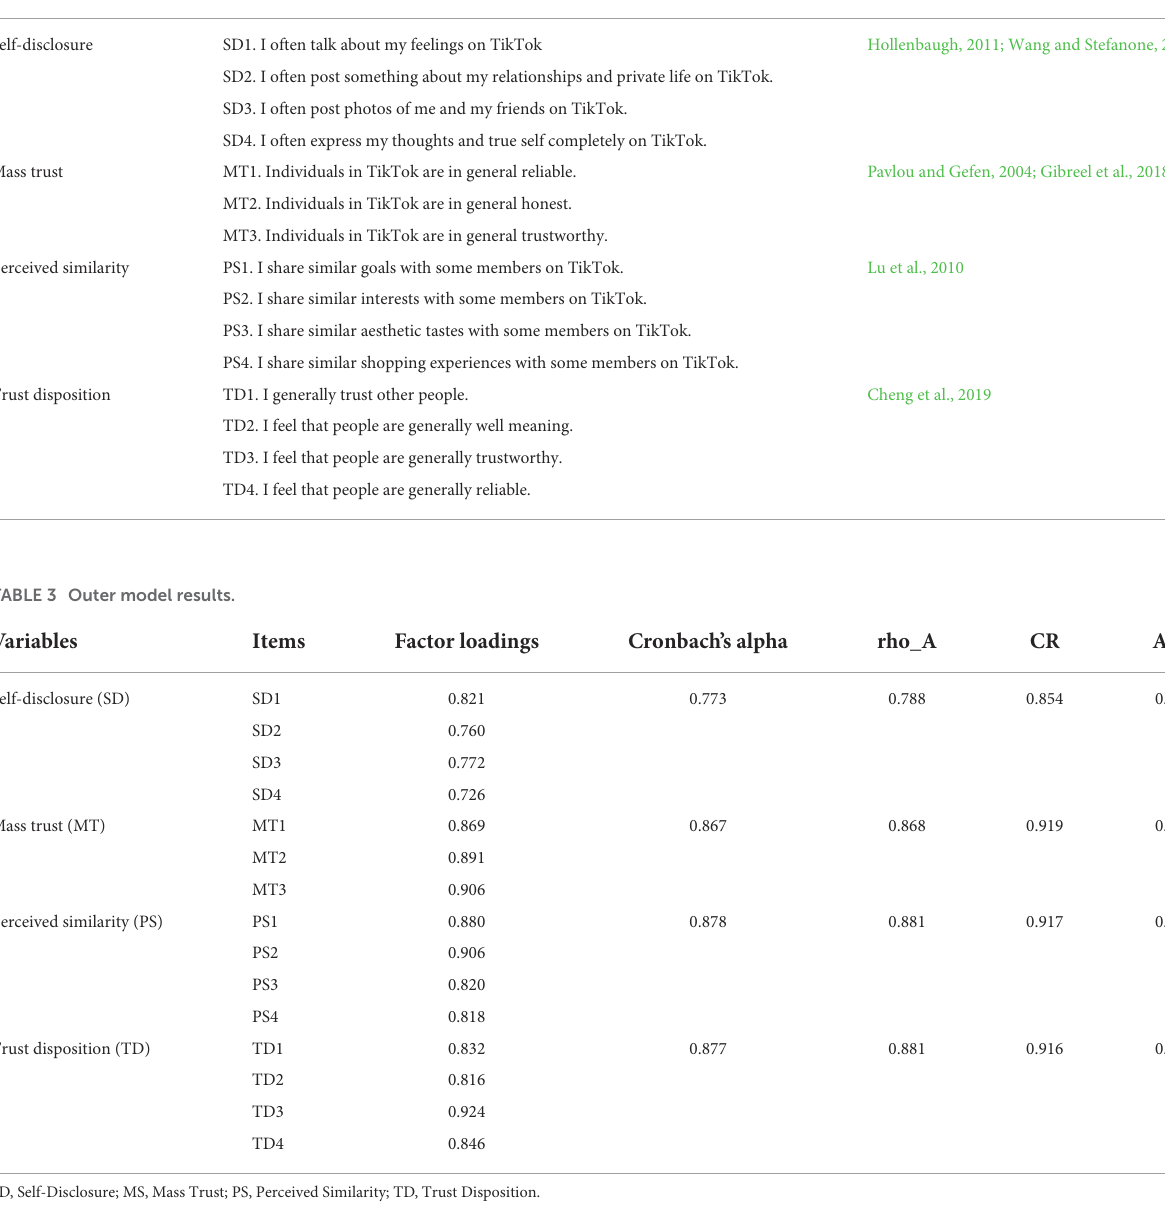
TABLE 2 Variables and measurement item.